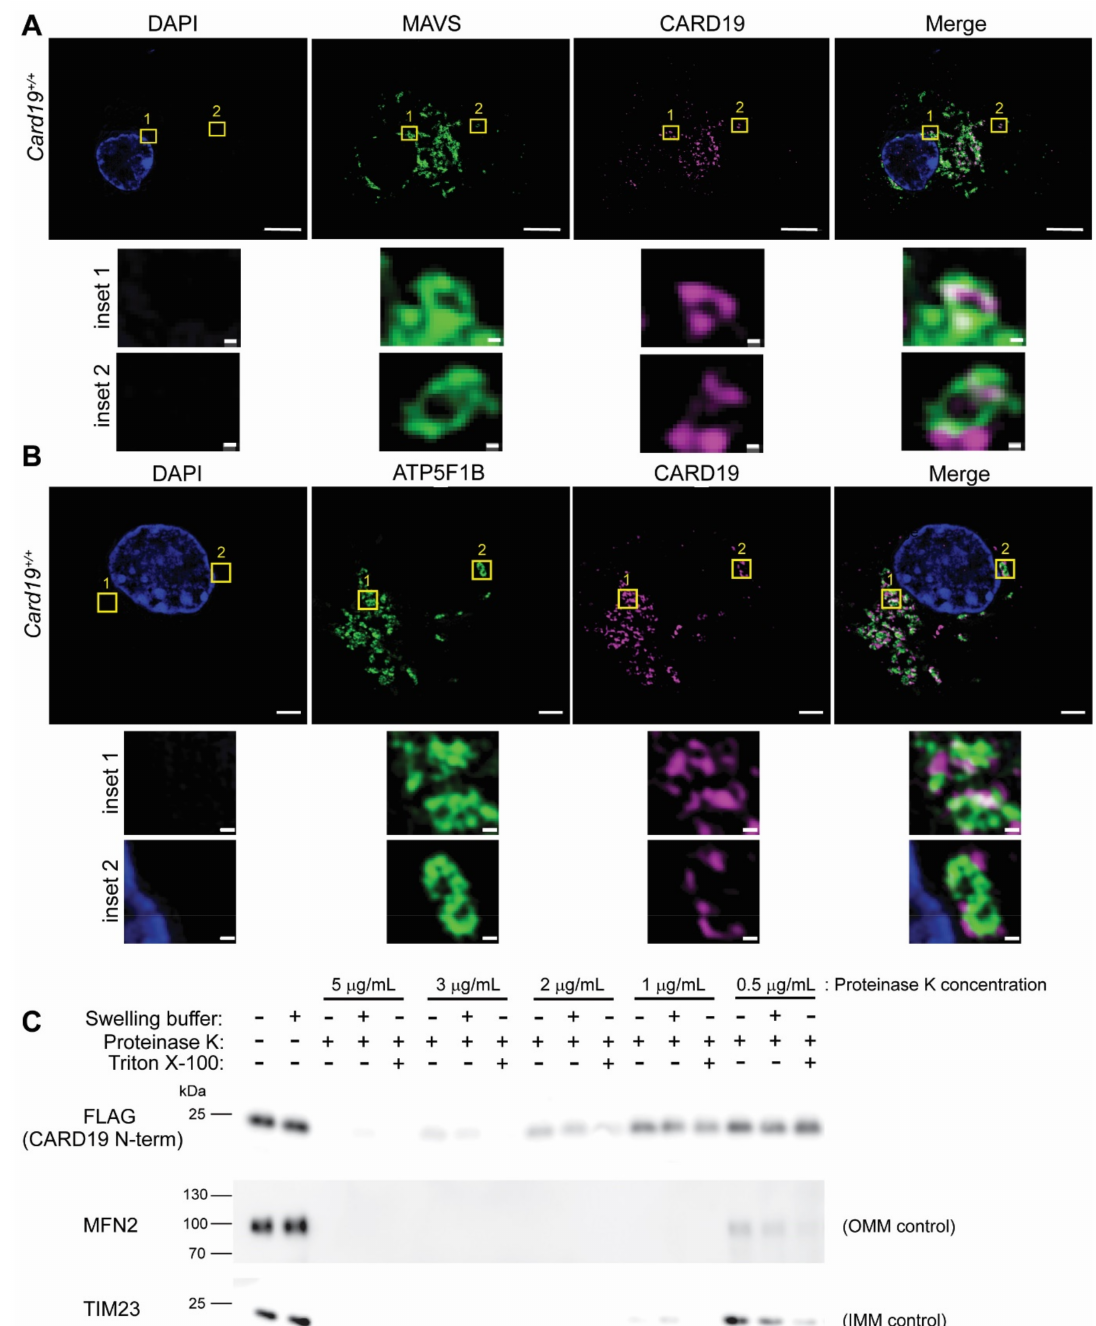
Figure 1. CARD19 localizes to the outer mitochondrial membrane. ( A ) BMDMs isolated from Card19 +/+ mice were labeled with anti-MAVS and anti-CARD19. DAPI was included to stain nuclear DNA. SIM images were collected with an ELYRA PS.1 and processed in Zeiss Zen Black. A repre- sentative image and insets are shown. The scale bar in the image corresponds to 5 µ m, and the scale bars in the inset correspond to 0.2 µ m. ( B ) The same as A, but cells were stained with anti-ATP5F1B, anti-CARD19 and DAPI. ( C ) Mitochondria were isolated from a Card19 − / − fibroblast cell line stably expressing 3 × FLAG-CARD19. A proteinase K protection assay was performed as a titration, using various concentrations of proteinase K, swelling buffer or Triton X-100 in the indicated lanes. Samples were separated by SDS-PAGE followed by immunoblotting with anti-FLAG to label FLAG-CARD19, the OMM marker Mfn2, and the IMM marker